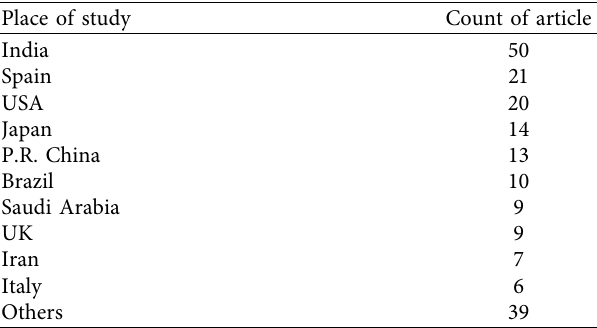
Table 1: The country-wise distribution of the place of study and the count of article.